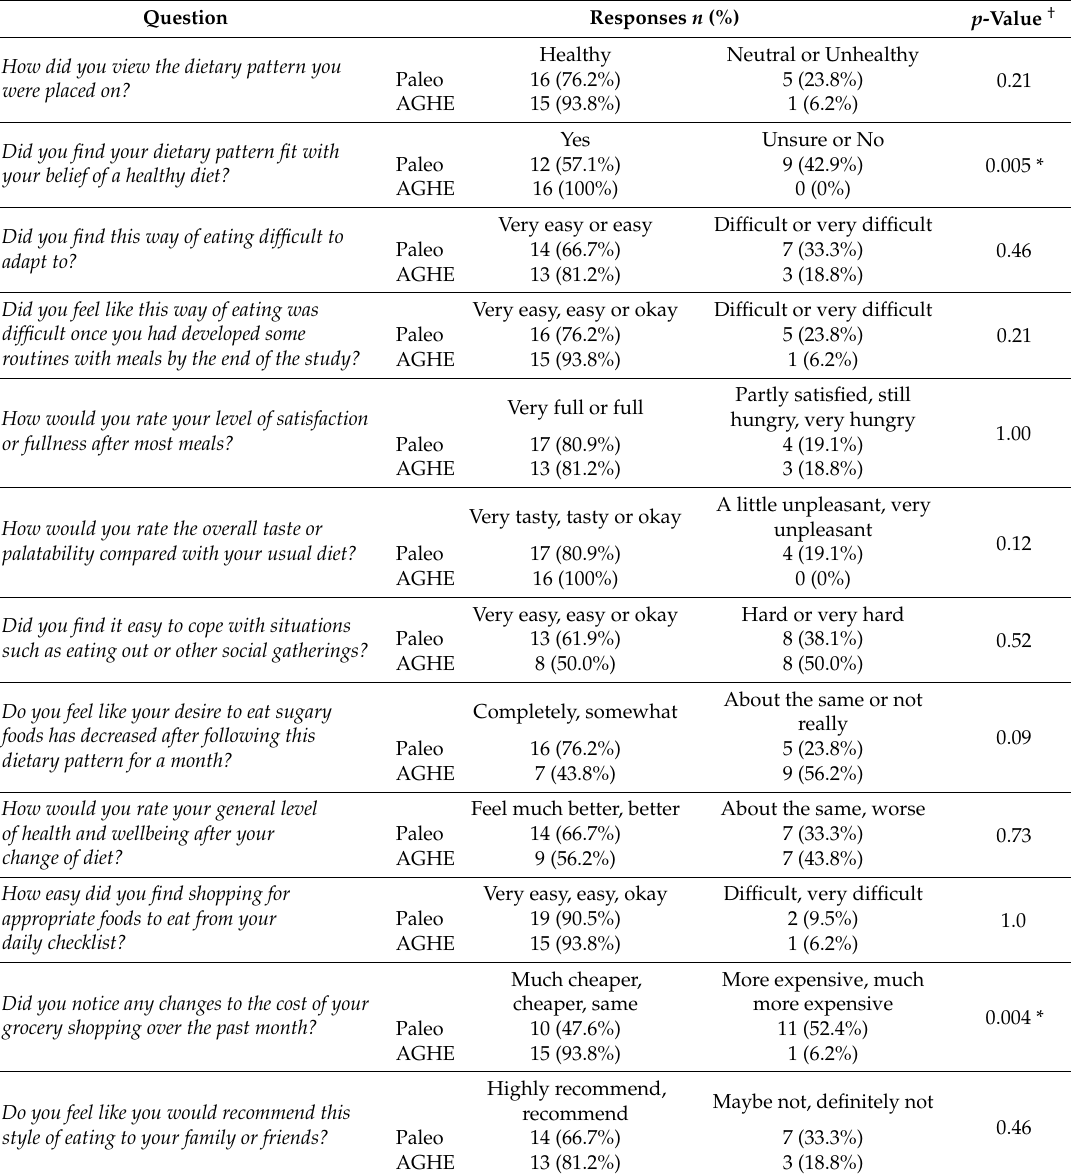
Table 3. Proportion responses collated from Palatability and Feasibility